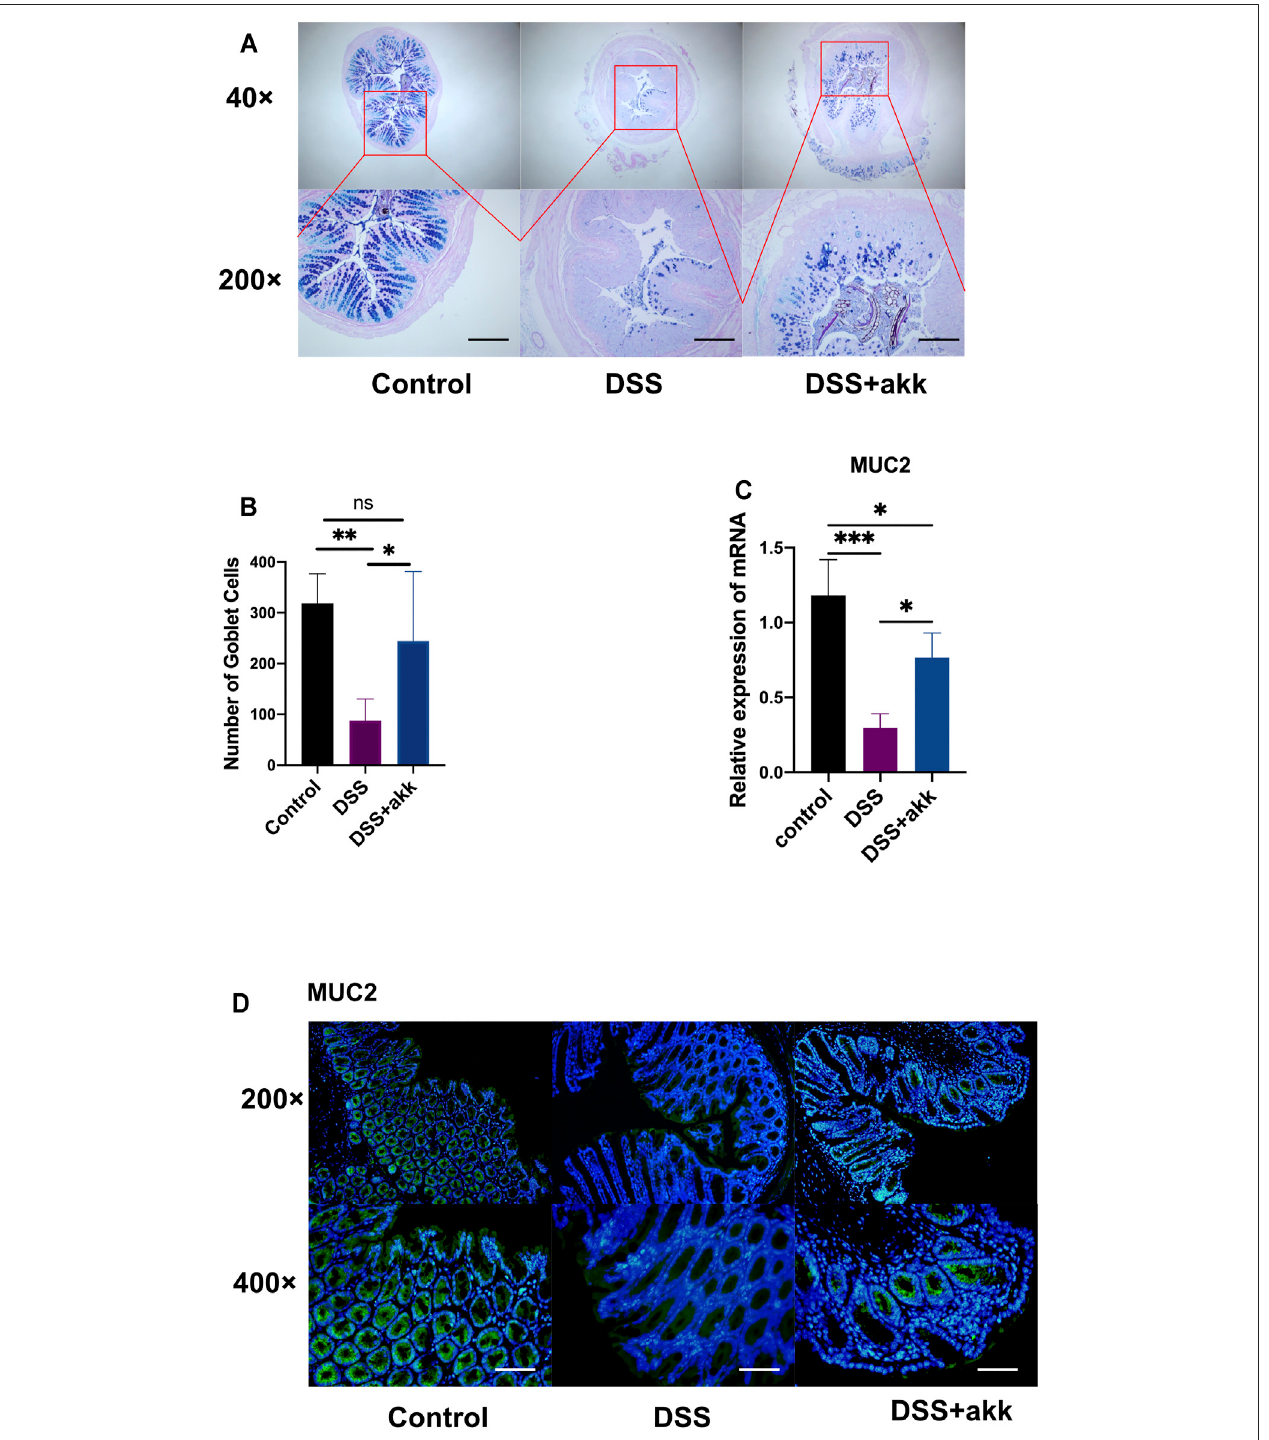
FIGURE 8 | Akkermansia muciniphila protects the mucus barrier in ulcerative colitis (UC). Alcian blue-periodic acid-Shiff (AB-PAS) staining of colon tissue (scale bars, 400 μ m) ( n (cid:1) 6 – 7) (A) and count of goblet cells ( n (cid:1) 6 – 7) (B) , RT-qPCR assay of mucin 2 (MUC2) ( n (cid:1) 3 – 4) (C) , and immuno fl uorescence assay of mucin2 protein detection in colon tissue (scale bars, 200 μ m) ( n (cid:1) 4) (D) and statistical comparison was made using an ANOVA test followed by Tukey-Kramer post-hoc tests. * p < 0.05, ** p < 0.01, *** p < 0.001, ns, no signi fi cance.